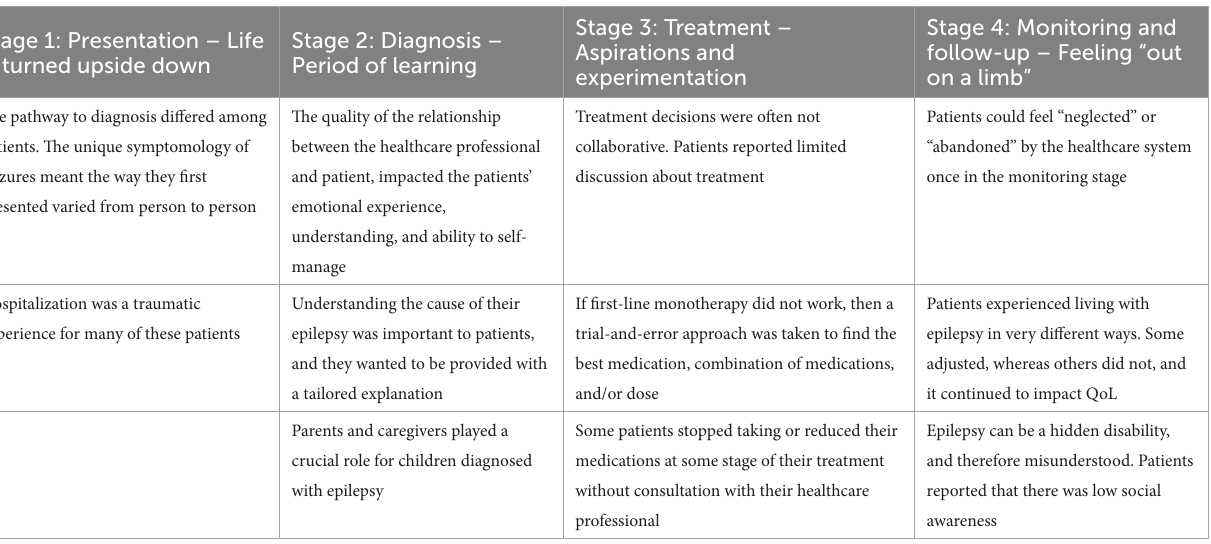
TABLE 4 Key insights at each stage of the patient journey. Stage 1: Presentation – Life is turned upside down